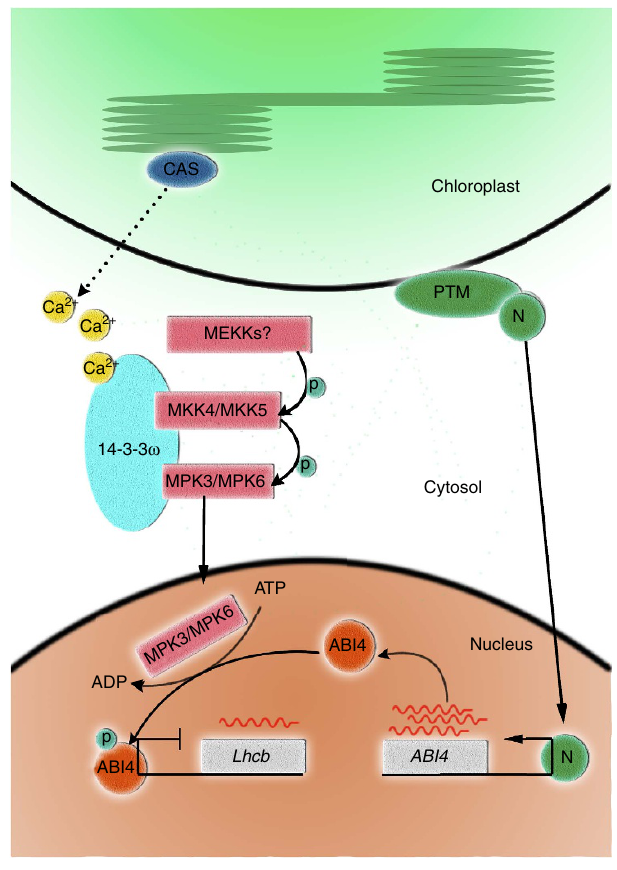
Figure 7 | A model illustrating the transcriptional and posttranslational regulation of ABI4 by PTM and MPK3/MPK6 in retrograde signalling. Scheme illustrating the regulation of ABI4 activity during retrograde signalling by transcriptional (PTM) and post-translational (MPK3/MPK6) mechanisms. Perturbations of plastid tetrapyrrole biosynthesis or inhibition of plastid gene expression can elicit a transient increase in the cytosolic Ca 2 þ concentration, and thylakoid-localized CAS protein is involved in the generation of cytosolic calcium transients, possibly as a result of the Ca 2 þ mobilization from chloroplast in response to lincomycin and NF treatments.